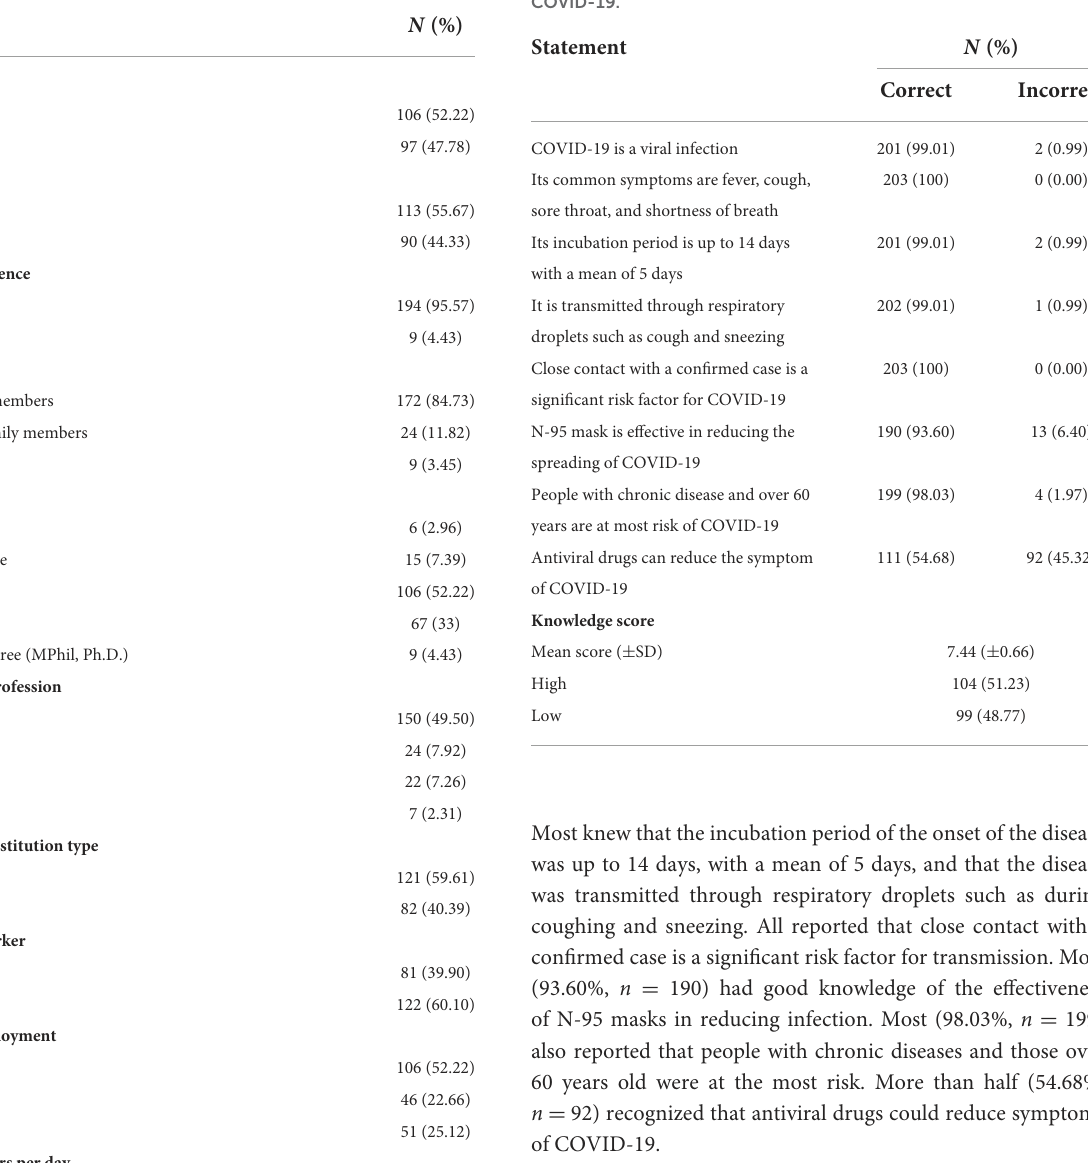
TABLE 1 Sociodemographic features of the respondents ( N = 203). TABLE 2 Knowledge assessment of healthcare professionals during